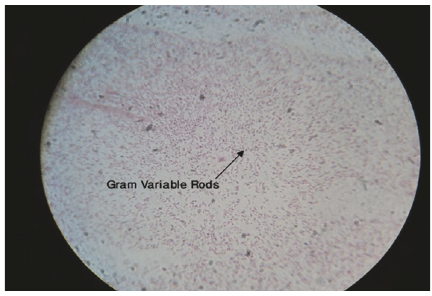
Figure 2: Gram-stained vaginal smears with Gram variable